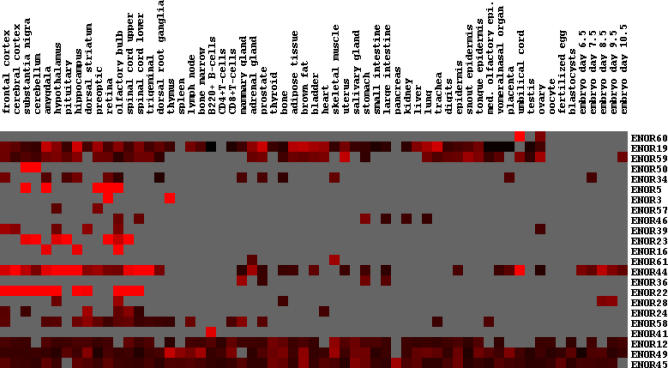
ENOR Tissue ExpressionTissue expression information for individual ENORs was obtained using publicly available GNF Gene Expression Atlas data. GNF probes that overlapped ENORs were identified, and the corresponding relative expression ratios for 61 tissues were hierarchically clustered. Red squares indicate high expression, black squares indicate low expression, and grey squares indicate where expression was not reliably detected (based upon Affymetrix MAS5 absent/present calls). med. olfactory epi., medial olfactory epithelium.